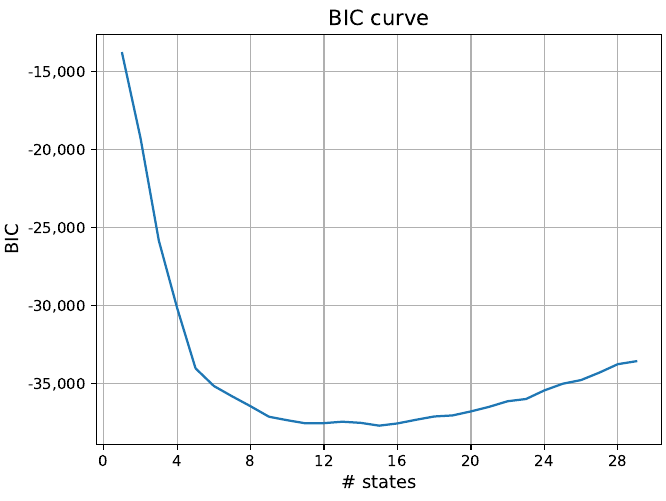
Figure 7. BIC as a function of the number of states in the GHMM.